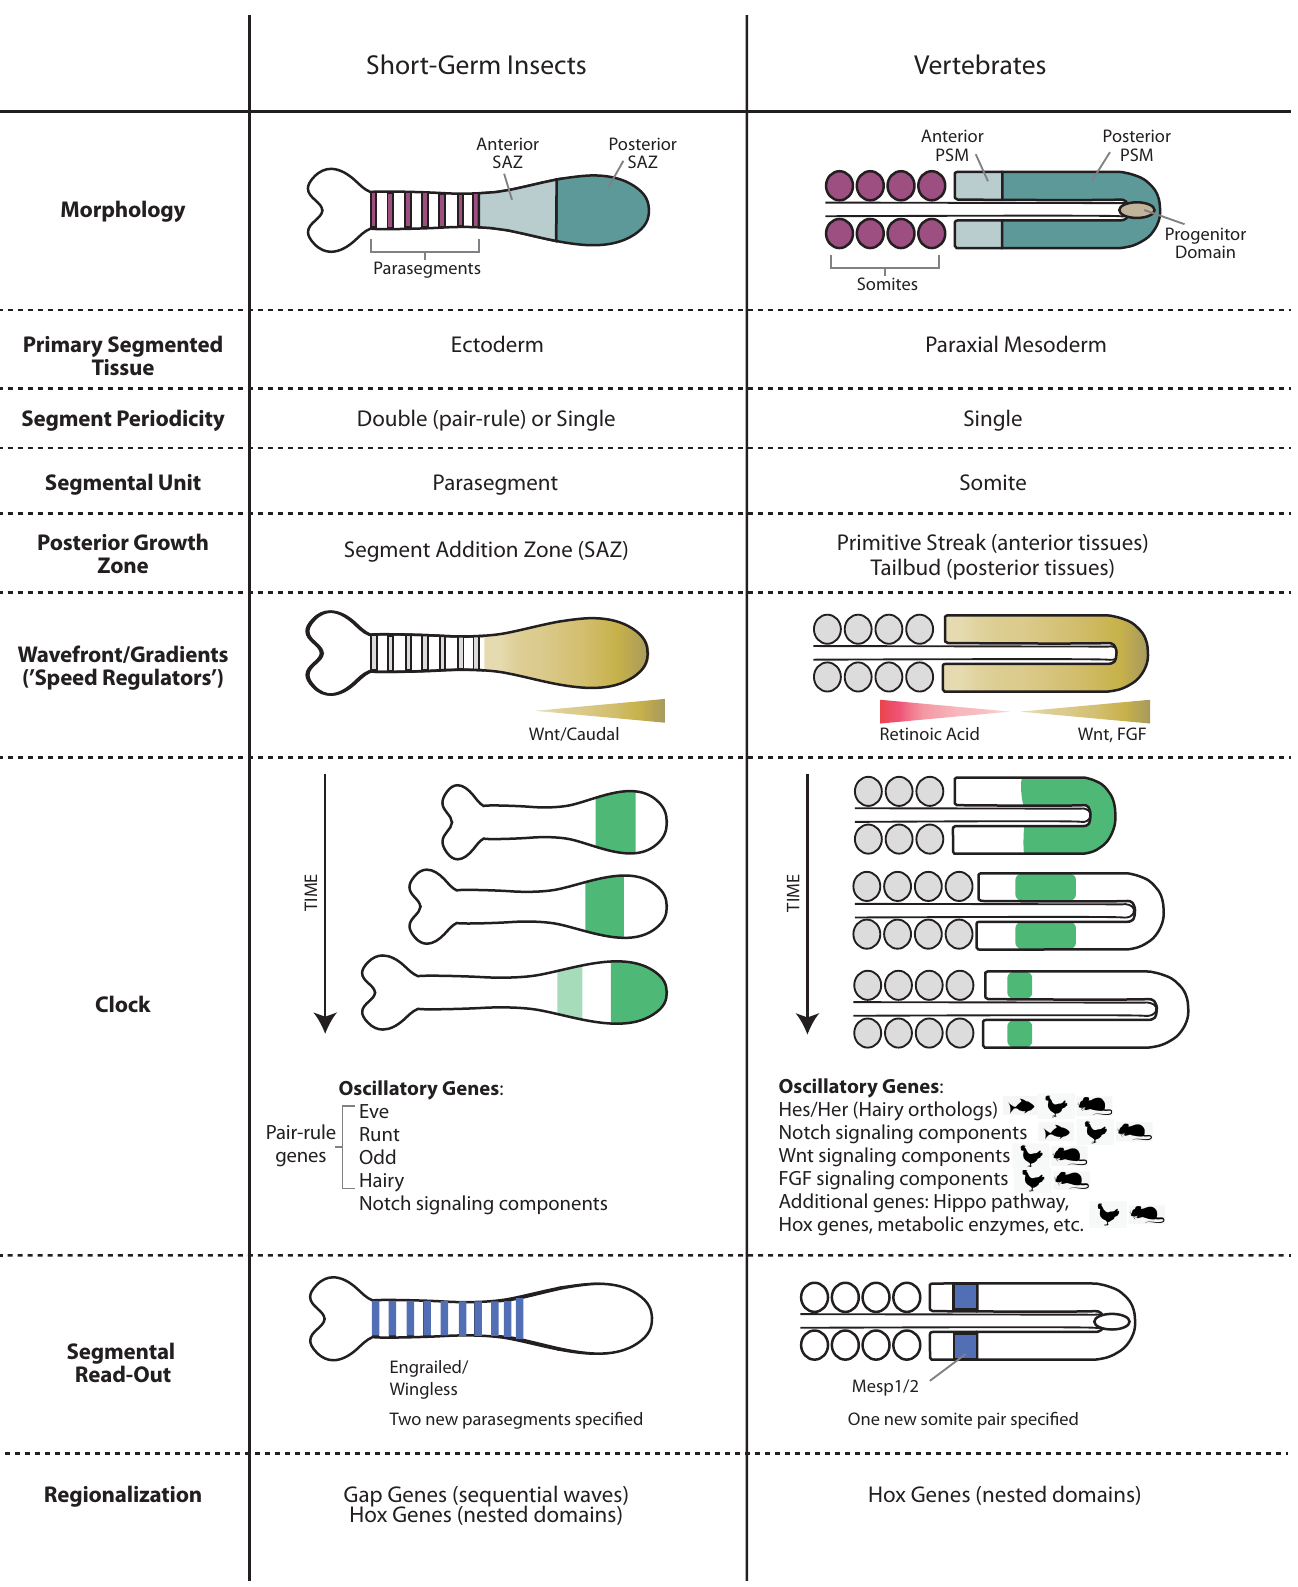
Fig 9. Comparison of segmentation and regionalization in short-germ insects versus vertebrates. PSM, presomitic mesoderm; SAZ, segment addition zone.